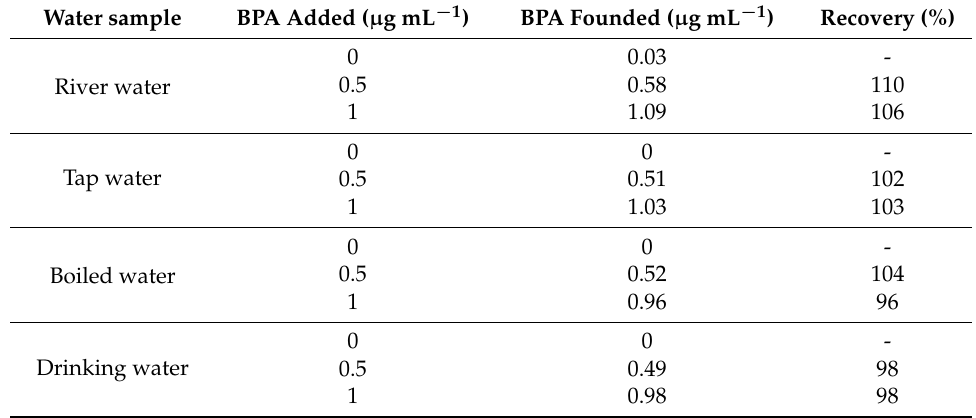
Table 2. Results of recovery tests on water samples.